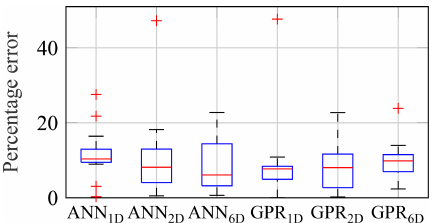
Figure 15. Percentage errors of predicted yearly damage values us- ing a functional relationship compared to real yearly damage values. Comparison of GPR and ANN and different EOCs: v s (1D), v s and TI (2D), and all environmental conditions